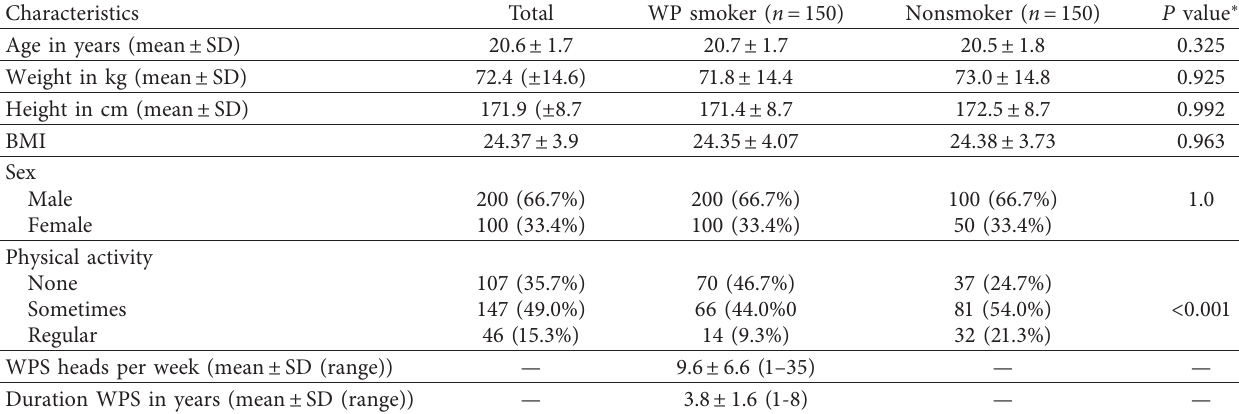
Table 1: Baseline characteristics of sample of waterpipe smokers and nonsmokers ( n � 300).